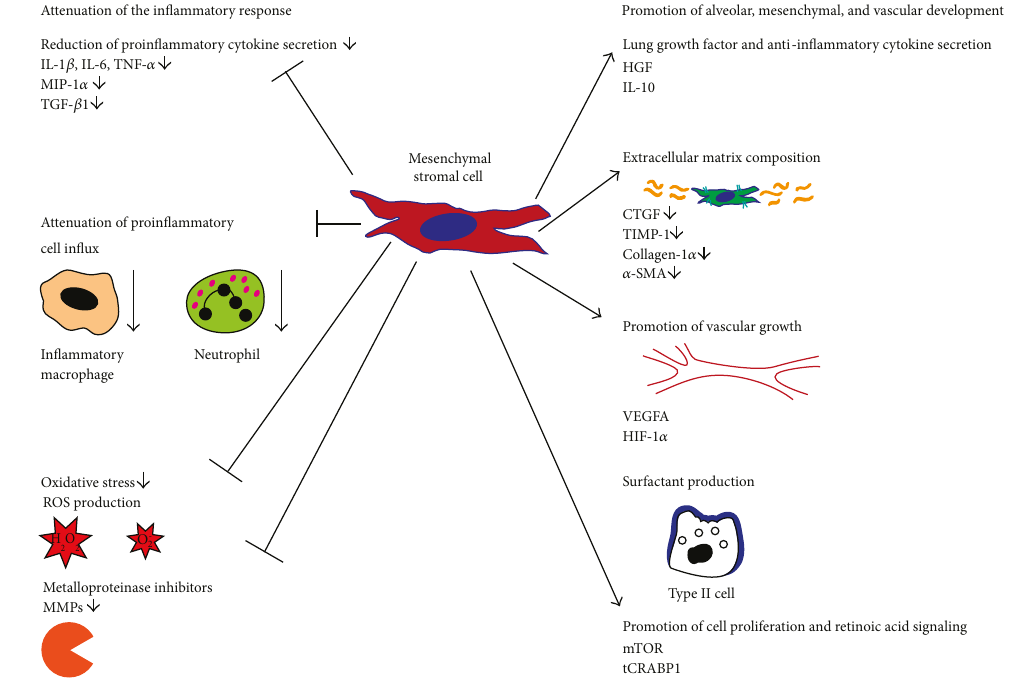
Figure 2: The therapeutic potential of allogenic mesenchymal stromal cells: allogenic MSC transplantation for prevention or therapy of lung injury has been studied in detail in the rodent model. The scheme summarizes all bene fi cial e ff ects following allogenic MSC therapy with separation of the positive e ff ects on in fl ammation and organ